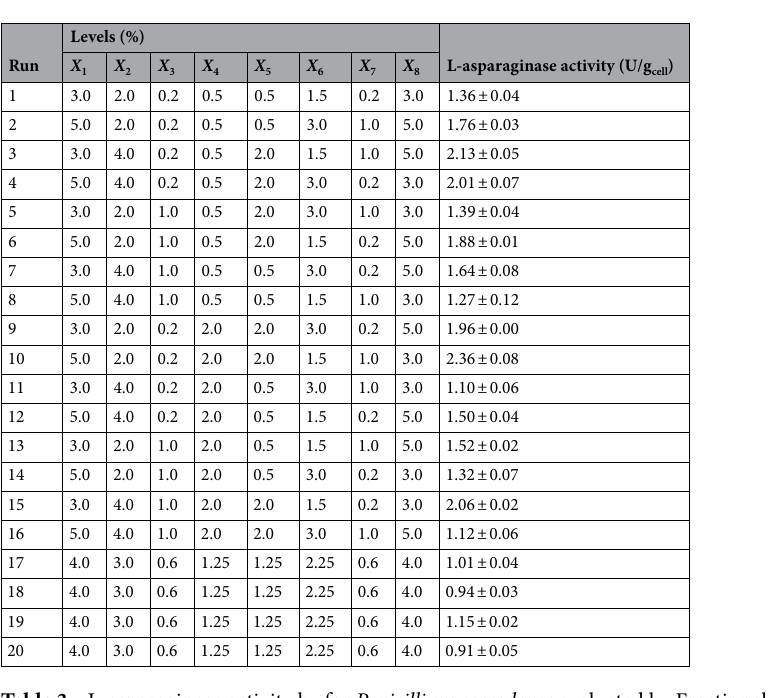
Table 3. L-asparaginase activity by for Penicillium cerradense evaluated by Fractional Factorial Design. L-proline (